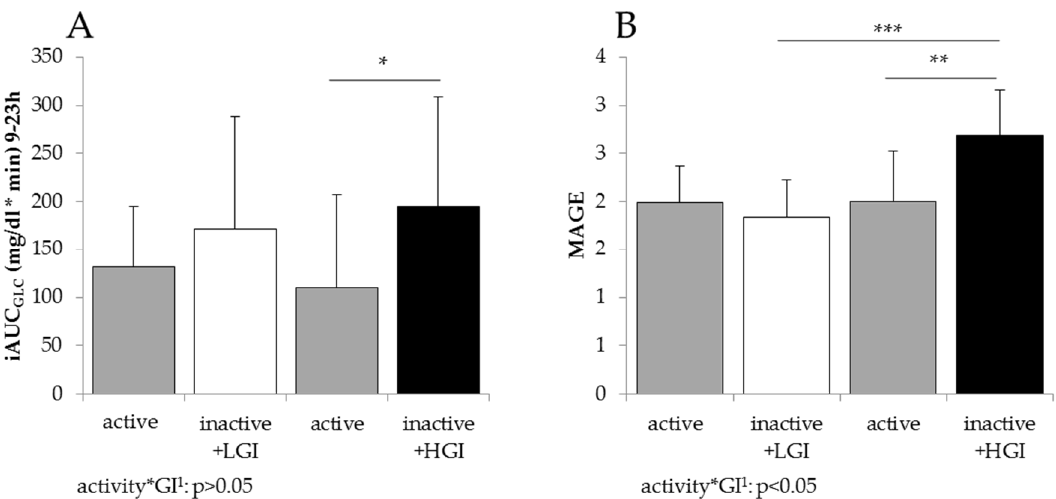
Figure 3. Daytime glycemia (iAUC GLC , A ) and glucose variability (MAGE, B ) during active